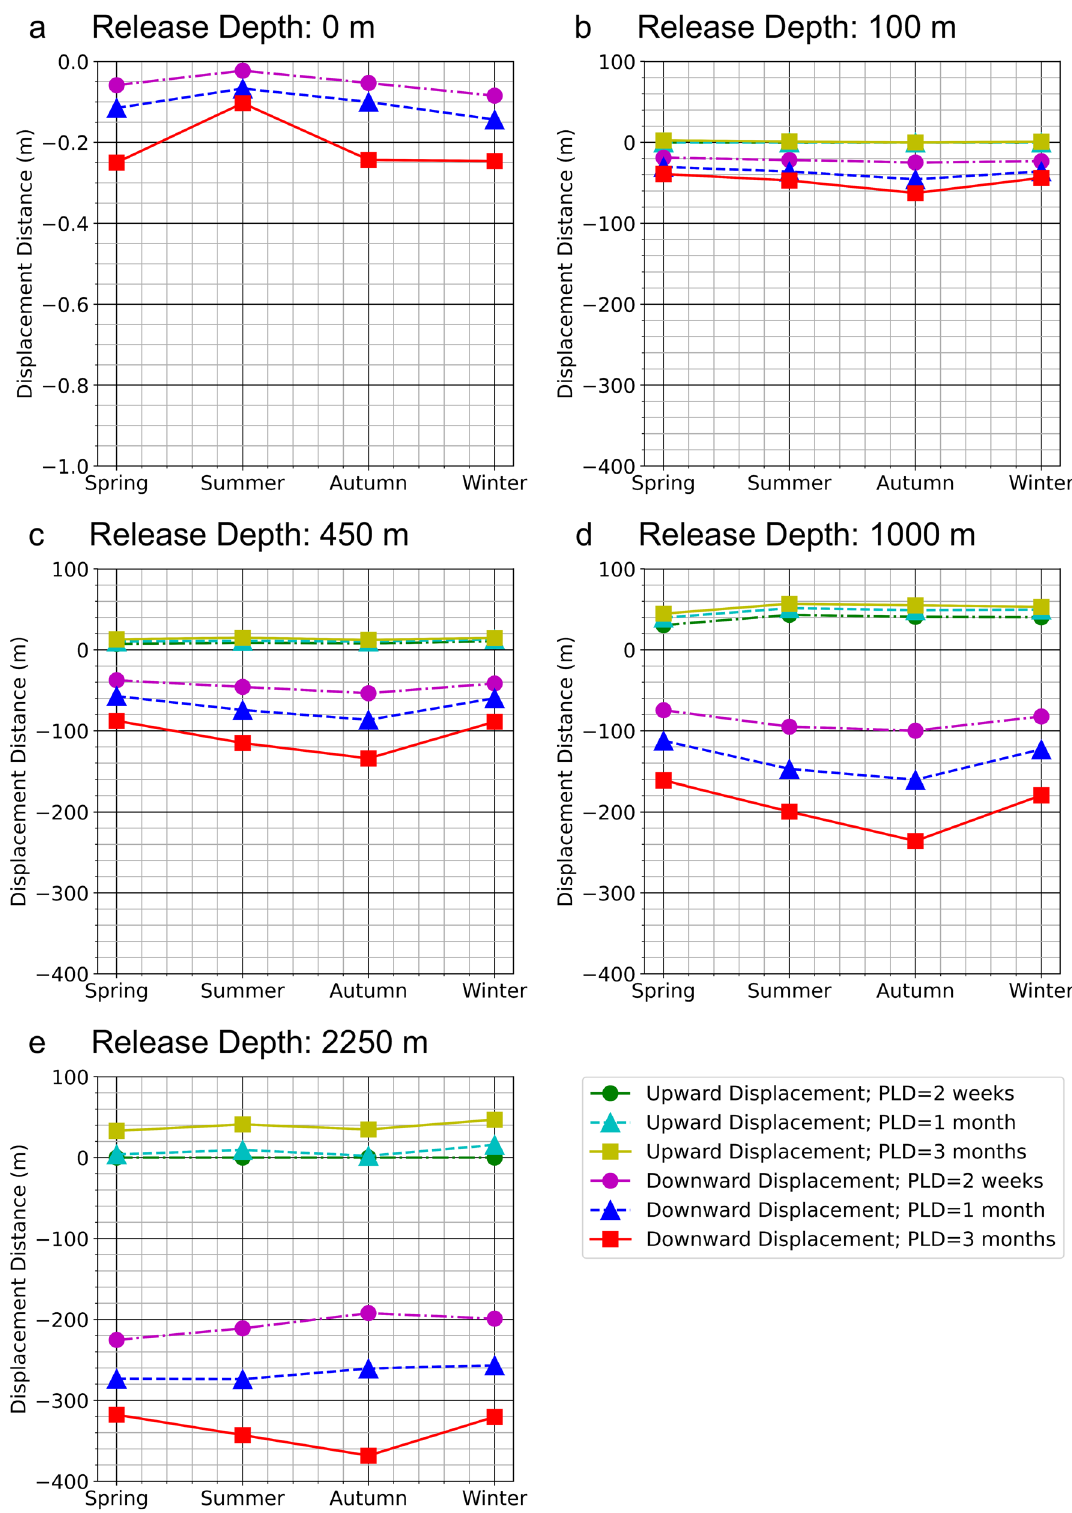
Figure 3. Seasonal Vertical Particle Displacements. Upward and downward travelling distances in each of four northern hemisphere seasons with different particle release depths (( a – e ) Surface, 100 m, 450 m, 1000 m and 2250 m) and pelagic larval drift durations (PLD; 2 weeks, 1 month and 3 months) in terms of the depths at which 50% of the forward-tracked particles released where able to reach. Positive and negative values denote upward and downward movements,